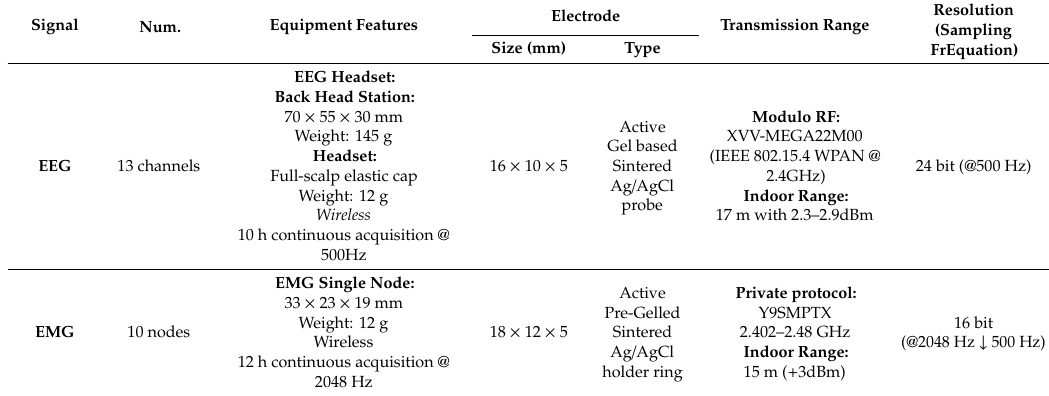
Table 5. EEG / EMG acquisition devices